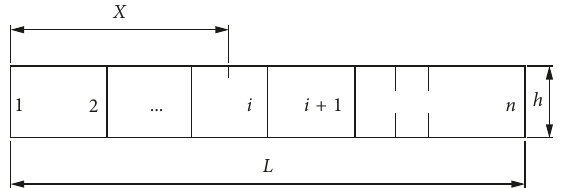
Figure 2: Finite element model of the cracked beam structure.